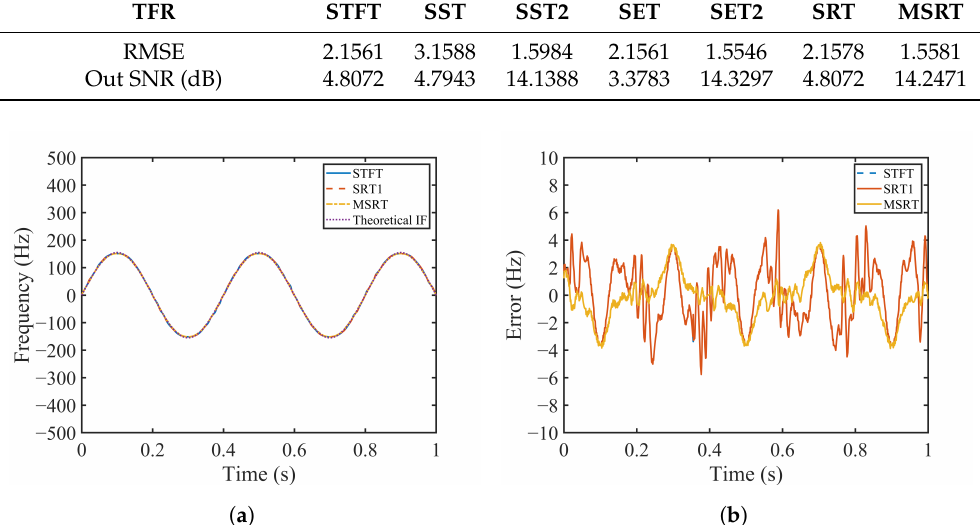
Figure 7. IF estimates and errors. ( a ) The instantaneous frequency estimate of the scatter A by different TFAs. ( b ) IF estimation